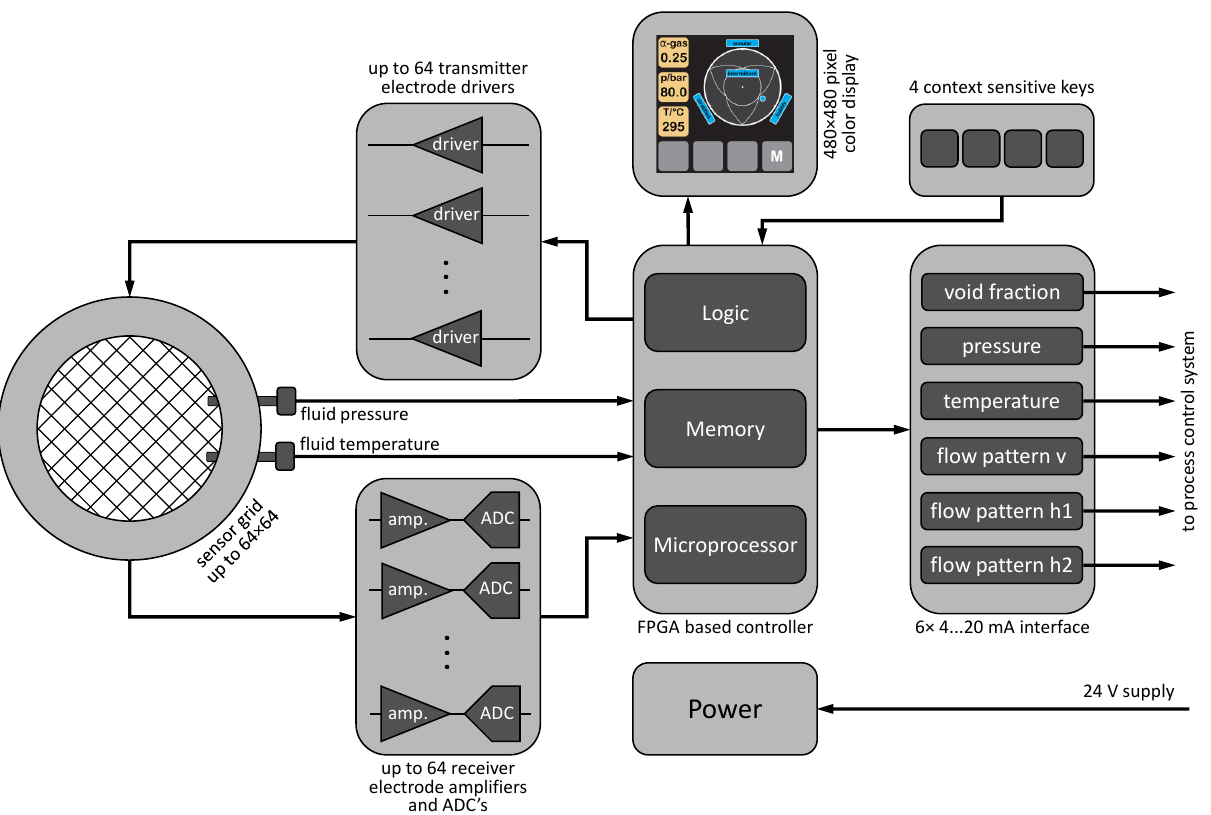
Figure 2. Block diagram of the electronic